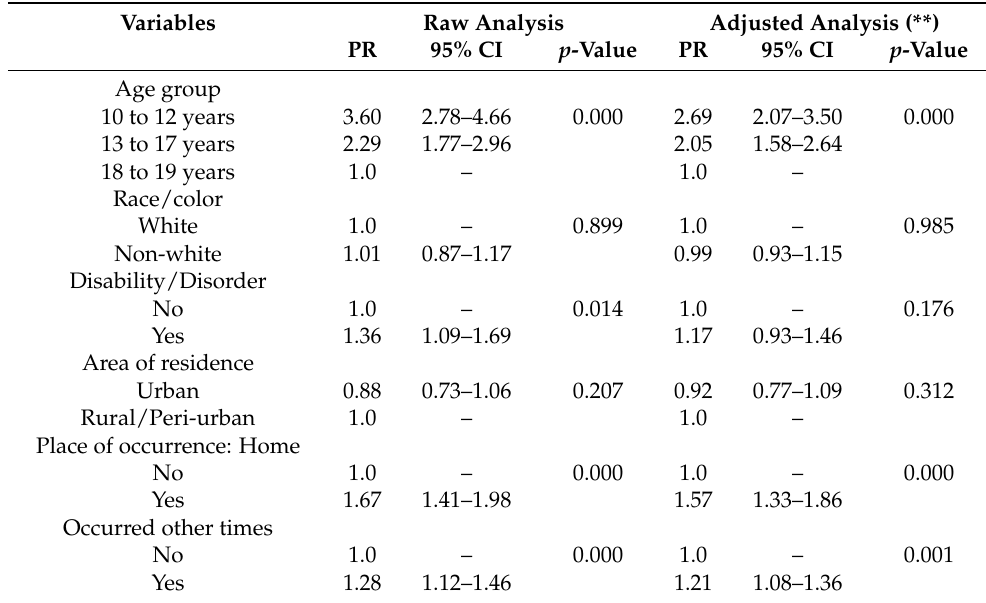
Table 3. Raw and adjusted analysis of the effects of the characteristics of cases of sexual